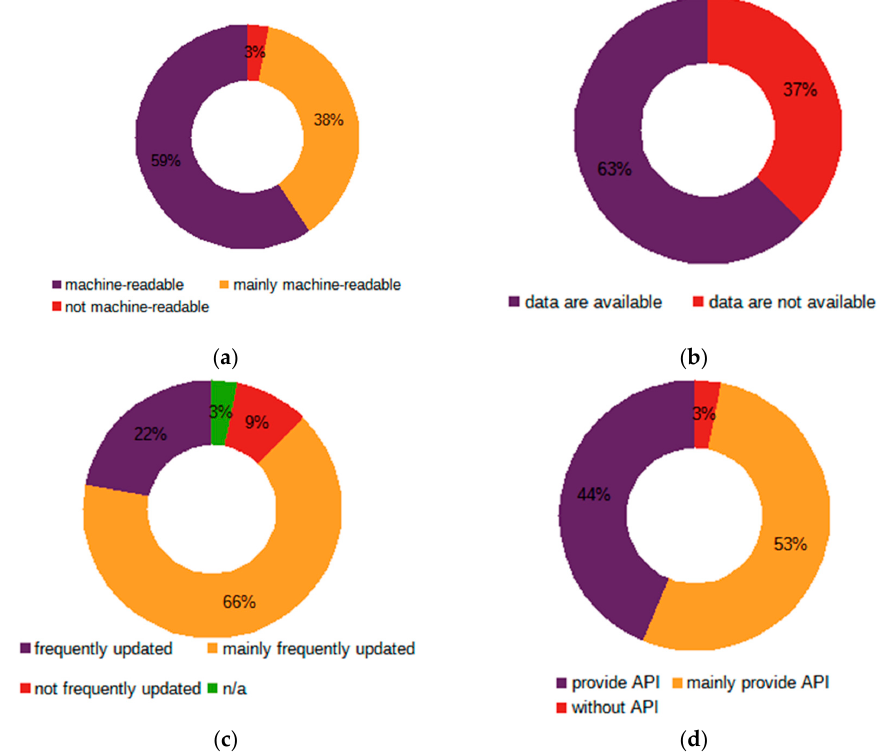
Figure 2. ( a ) Real-time data availability on 51 OGD portals; ( b ) Real-time data machine-readability; ( c ) Real-time data currency, i.e., frequency of updates; ( d ) API presence.